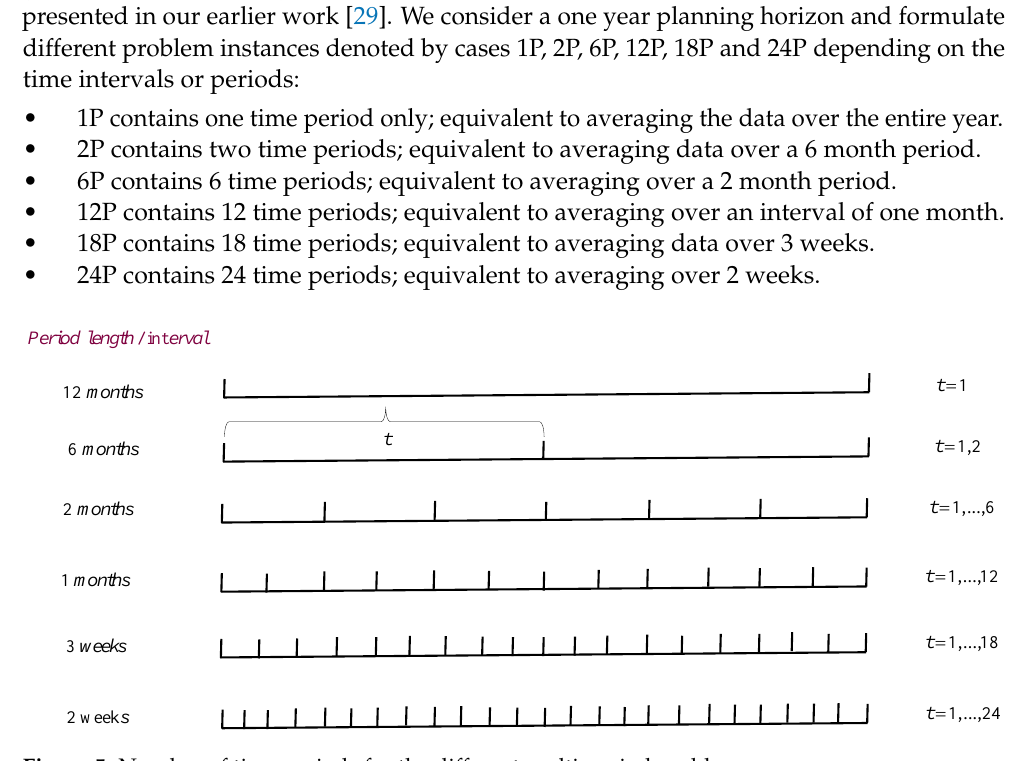
Figure 5. Number of time periods for the different multi-period